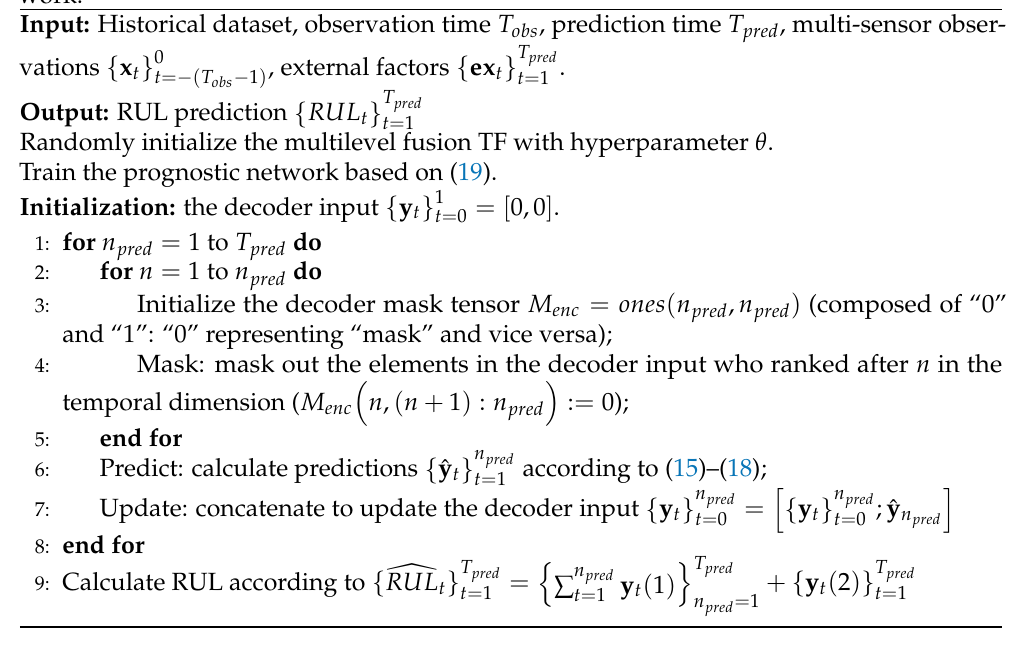
Algorithm 1 The online predicting process based on the multilevel fusion transformer net-